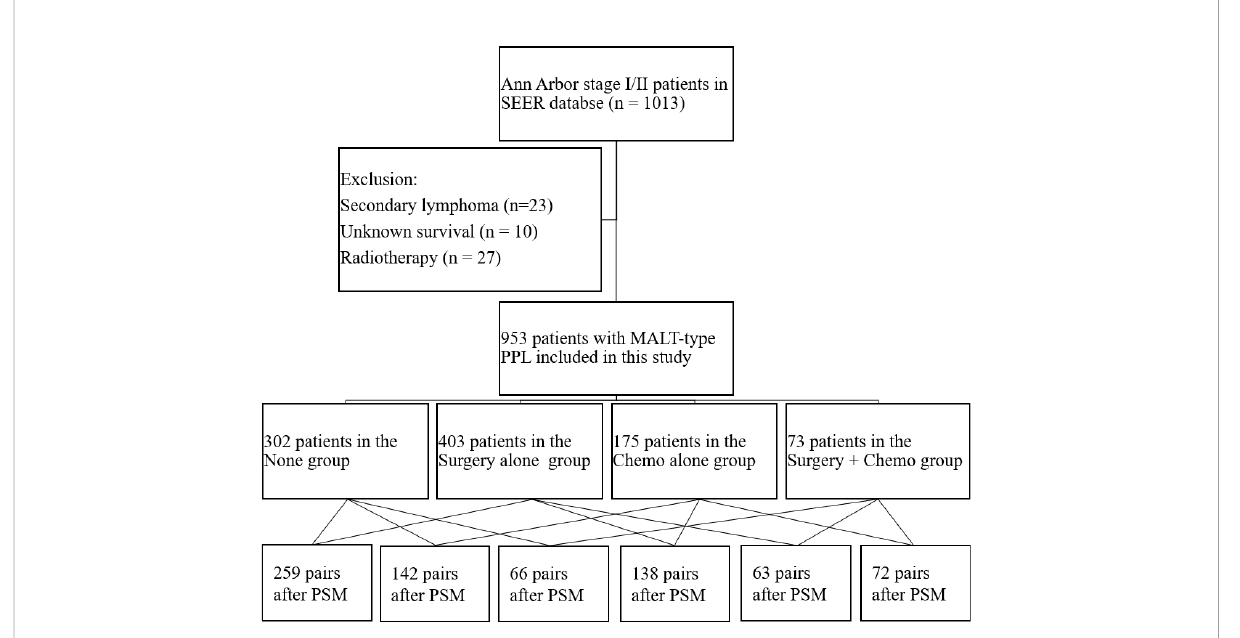
FIGURE 1 The schema and distribution of the study population. PSM: propensity score matching.